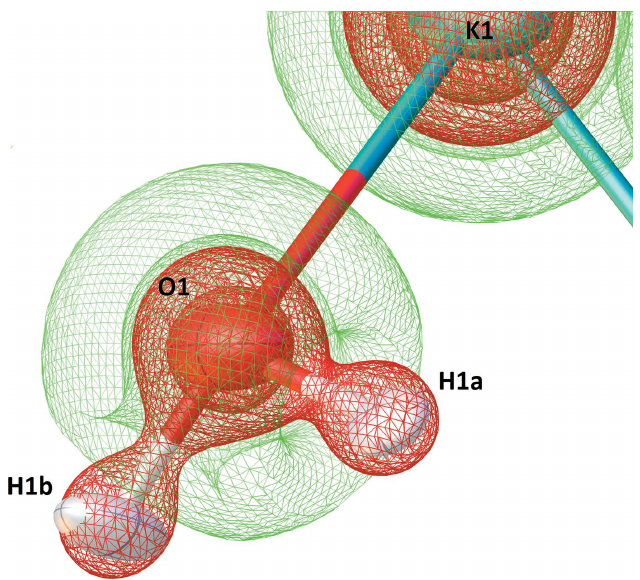
Figure 4 Three-dimensional wire map of the Laplacian of the electron density in the vicinity of the water molecule, at (cid:7) 0.25 e (cid:3) /A˚ 5 level. The positive isosurfaces (green) show where electron density depletion occurs (valence-atomic orbital regions), while negative isosurfaces (red) show regions where electron density accumulates (bonding-electrons energy densities). The map was calculated on a 0.05 A˚ grid in real space and was generated with OLEX2 (Dolomanov et al. ,